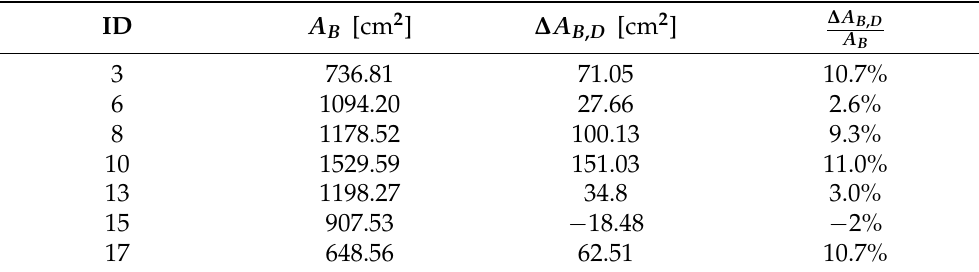
Table 6. Computed leaf areas A B of the plant p 6, acquired by the terrestrial laser scanner (TLS) as well as differences ∆ A B , D between the B-spline based leaf area determination and the digitizer